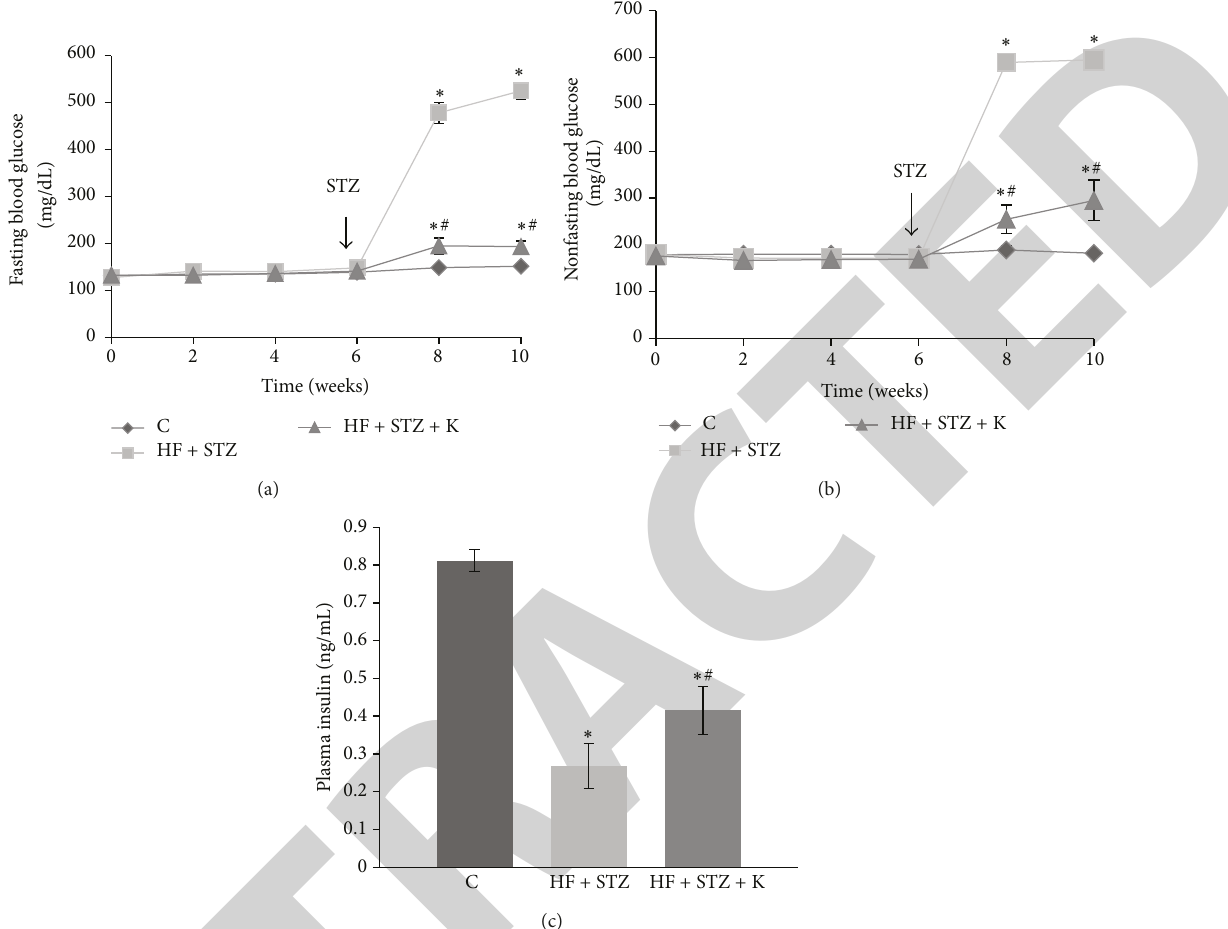
Figure 6: Dietary intake of kaempferol ameliorated hyperglycemia in STZ-induced obese diabetic mice. Male C57BL/6 mice (10-month-old) were fed a HF diet or HF diet containing 0.05% kaempferol (HF + K) in the diet for 6weeks prior to administration of STZ (40mg/kg for 3 consecutive days) and continued on the same diet for 4 weeks. Age-matched mice were fed a SD diet (C). Fasting (a) and nonfasting blood glucose levels (b) were monitored biweekly throughout the study. (c) Plasma insulin levels in fasted mice were measured by ELISA. Data are means ± SE ( 𝑛 = 10 – 12 mice/group). ∗ 𝑝 < 0.05 versus healthy control (C); # 𝑝 < 0.05 versus STZ alone-treated